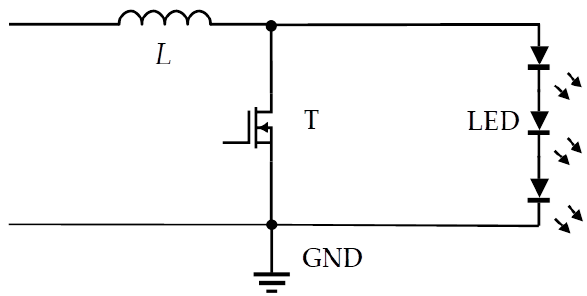
Figure 8. Simplified LED Boost converter.